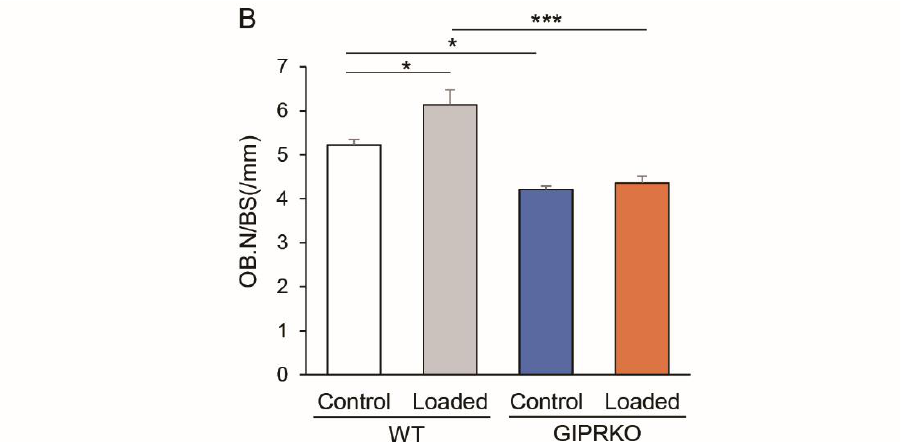
Figure 7. Evaluation of osteoblasts by ALP staining. Comparison of ALP-positive cells on the traction side of M1M. ( A ) ALP-stained micrographs of the loaded side of the WT and GIPRKO. Black arrow head points to osteoblast. Scale bar: 100 μm. ( B ) Comparison of changes in the osteoblast number per BS (OB.N./BS). (* p < 0.05, *** p < 0.001). (WT: n = 5, GIPRKO: n = 4).